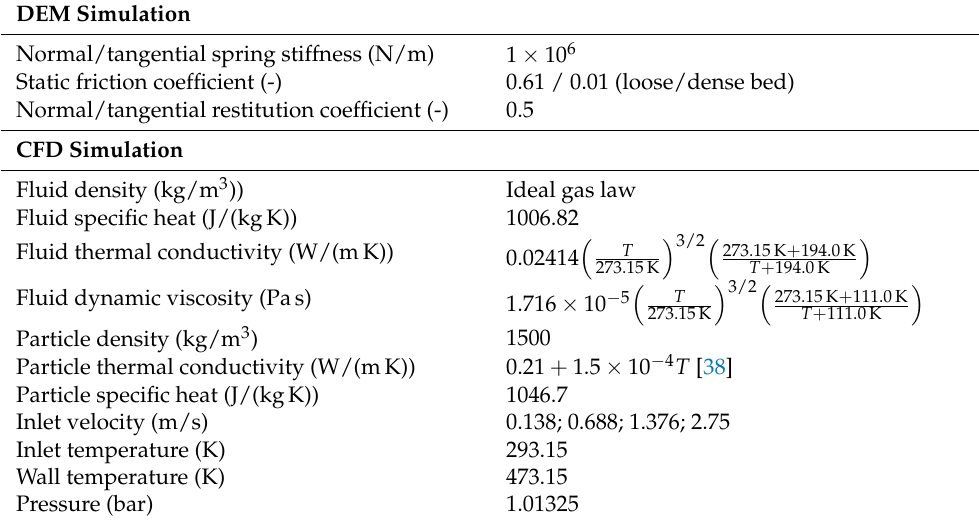
Table 1. Material properties and boundary conditions for the DEM and CFD